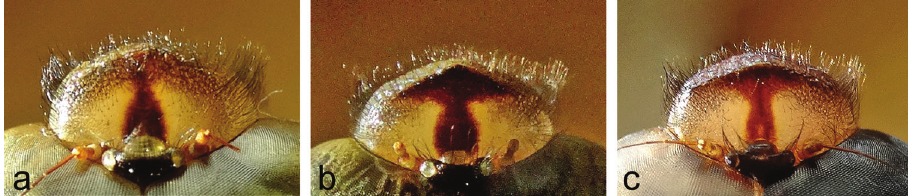
Figure 3. Frons in dorsal view, with a potentially diagnostic T-mark, of the individuals collected in Ch- ingombe, Zambia: a male of Gynacantha vesiculata b female of Gynacantha villosa c female of Gynacantha sp. (phot. R. Bernard).